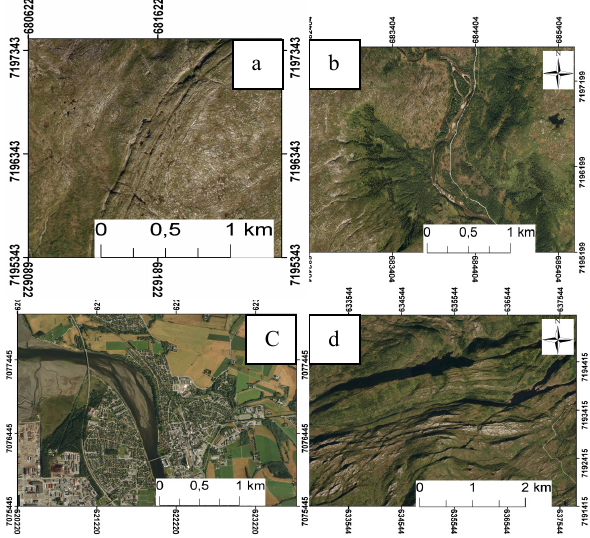
Figure 1 . Aerial images of the four test sites: The letter a - d correspond to the test site numbers 1-4 used in the text,